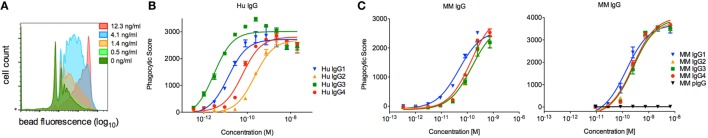
Characterization of the phagocytic activity of Macaca mulatta (MM) immunoglobulin G (IgG) subclasses and comparison to human IgG subclasses. (A) Exemplary flow cytometry histograms for a titration of MM IgG1 driving phagocytosis of CD8α-conjugated fluorescent beads. (B) Myeloma-derived human IgG1–4 were evaluated in the same assay measuring uptake of fluorescent beads, in this case using beads conjugated with an anti-human Fab reagent. Results from one representative experiment with technical replicates are presented. (C) Recombinant monoclonal rhesus macaque IgG (MM IgG1–4) was evaluated for its ability to drive phagocytosis of CD8α-conjugated fluorescent beads. Representative results from two of five independent experiments in which duplicate titrations were assessed are presented.